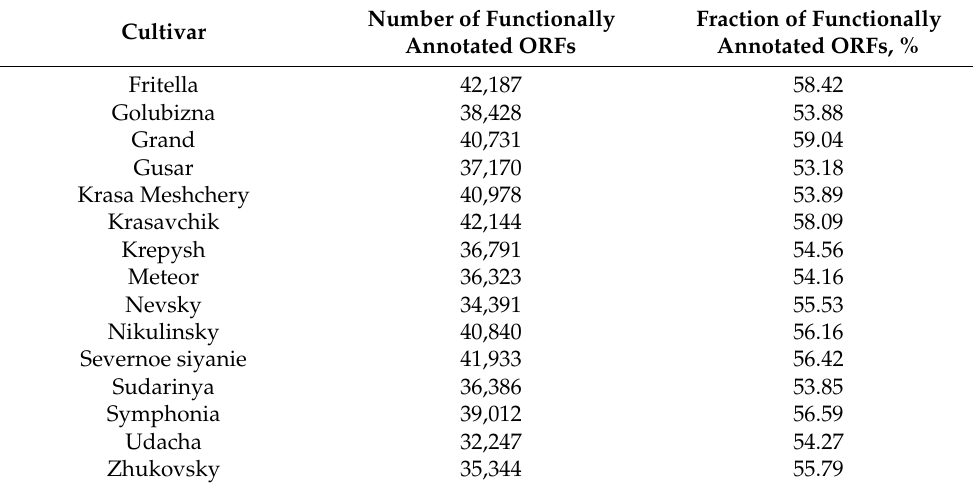
Table 3. The number and fraction of protein-coding genes in genomes of Russian cultivars annotated by InterproScan